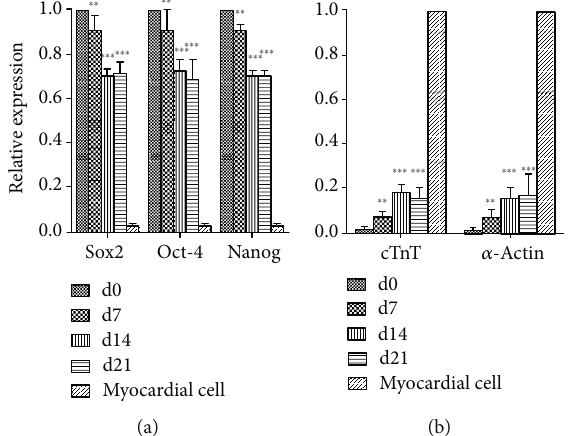
Figure 5: Gene expression levels in BM-VSELs di ff erentiated into cardiomyocytes after 5-AzaC treatment. Expression of (a) Sox2, Oct-4, and Nanog and (b) cTnT and α -actin was detected in 5-AzaC-treated cells via qRT-PCR. The gene expression levels of cardiomyocytes and pluripotent stem cell genes were normalized with GAPDH and compared to the relative control group and cardiomyocytes ( n = 3 , level of signi fi cance p < 0 : 05 ; ∗ p < 0 : 05 ; ∗∗ p < 0 : 01 ; ∗∗∗ p < 0 : 001